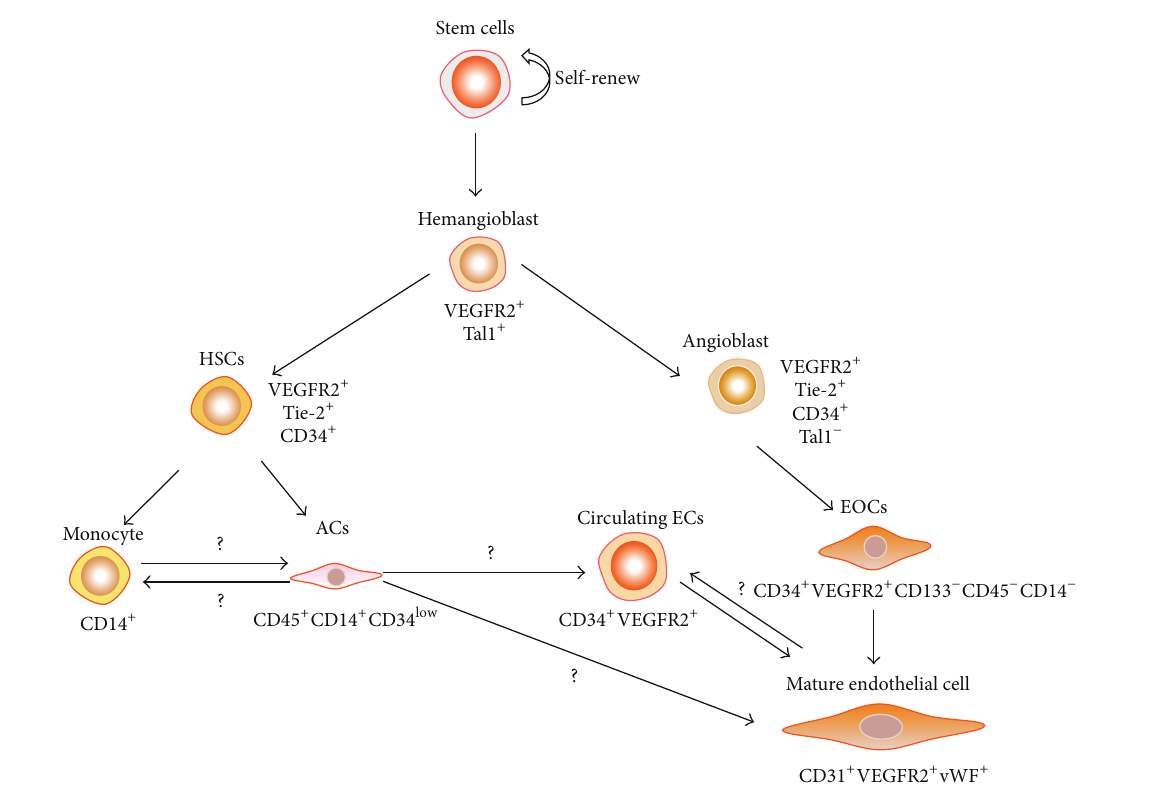
Figure 1: Adult endothelial progenitor cell phenotype (ACs: angiogenic cells; ECs: endothelial cells; EOCs: endothelial outgrowth cells; HSCs: hematopoietic stem cells; VEGFR: vascular endothelial growth factor receptor). Hemangioblasts derived from pluripotent stem cell can differentiate into HSCs and angioblasts. The HSCs give rise to blood cells, such as monocytes and ACs. Whether monocytes can act as ACs and vice versa is still controversial. Angioblasts give rise to endothelial cell lineage, including EOCs. Circulating endothelial cells can arise from the detachment of mature ECs and repair other areas of endothelium damage or can arise from the differentiation of